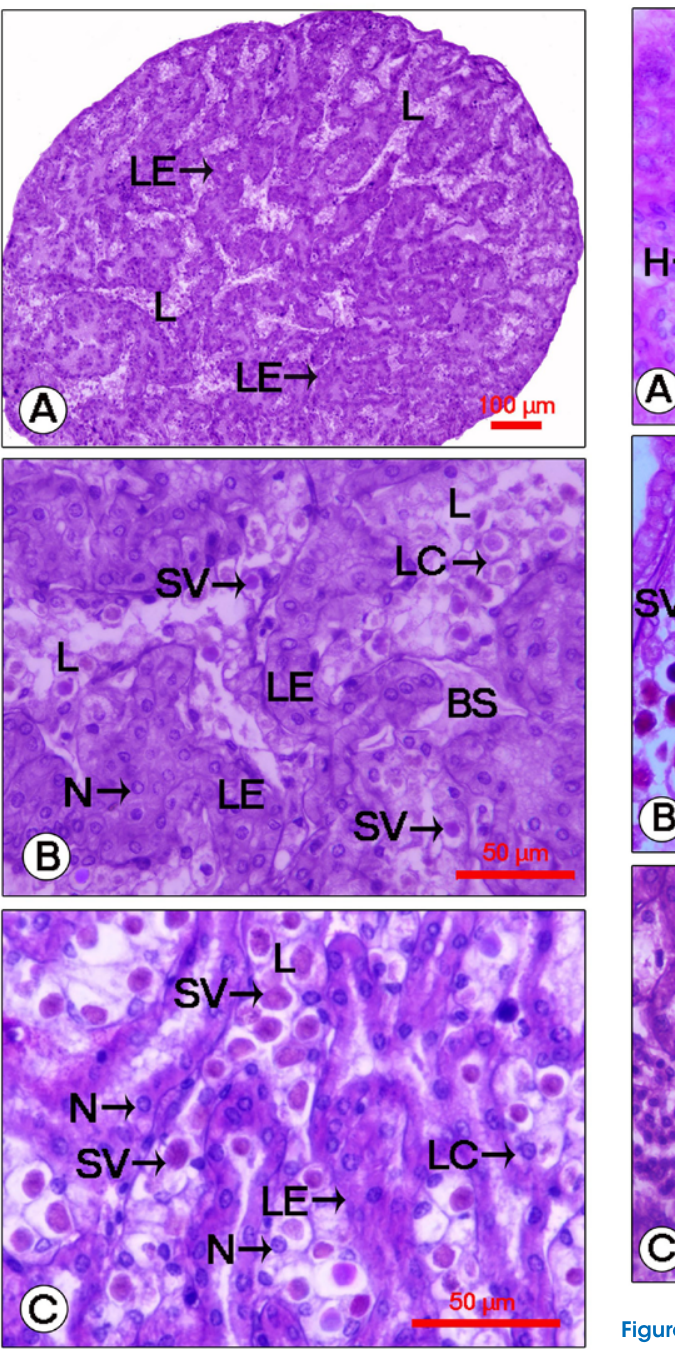
Figure 6. Light micrograph illustrating Y-organ of crabs treated with 20E during C4 stage in Travancoriana schirnerae. ( A ) Compactly packed lobules without inter-lobular spaces. ( B ) Lobules surrounded by multilayered epithelium. ( C ) Presence of large number of secretory vesicles in the lobules. BS: Blood sinus; L: Lobule; LC: Larger cell; LE: Lobular epithelium; N: Nucleus; SV: Secretory vesicle.